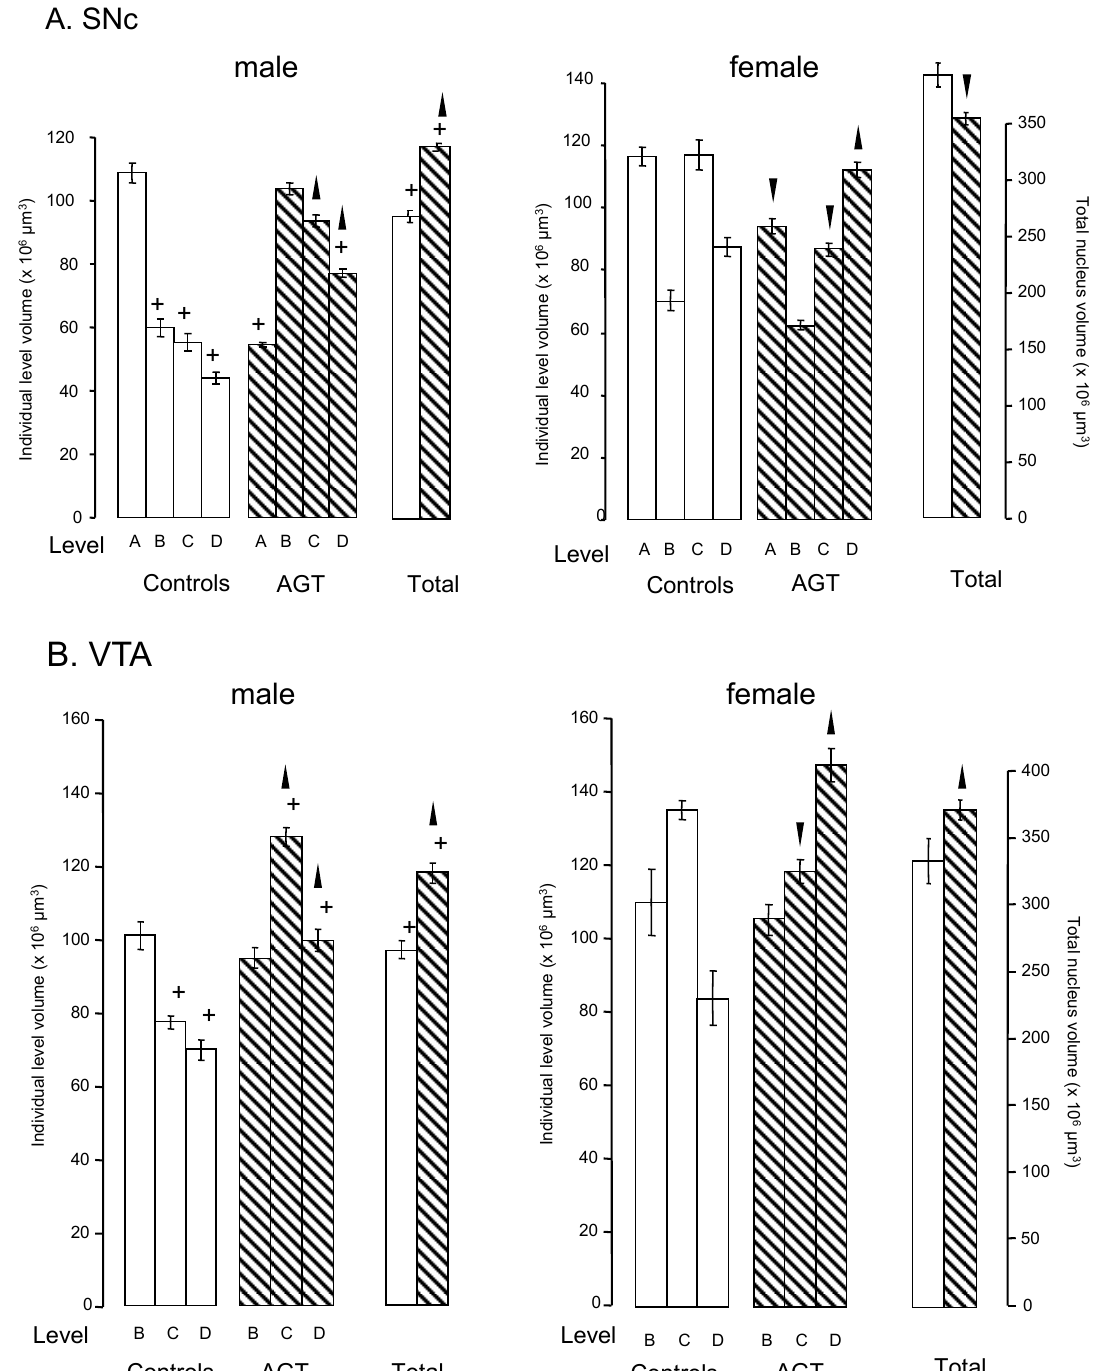
Figure 2. Influence of antenatal glucocorticoid treatment (AGT) on the volume (levels A–D and total) and overall shape of the adult rat SNc and VTA. Rats were exposed to AGT (dexamethasone via the maternal drinking water prenatally on embryonic (0.5 µg dexamethasone/mL in dams’ drinking water on gestational days 16–19, ) and volumes of the SNc ( A ) and VTA ( B ) in adulthood were compared to the control offspring of dams receiving normal drinking water ( ). Data are means ± s.e.m., n = 8 animals per treatment group. , indicates significant effect of treatment, p < 0.05, increased or decreased respectively, for dexamethasone treated vs. control animals; + indicates significant sex difference p < 0.05 vs. females in the same treatment group.